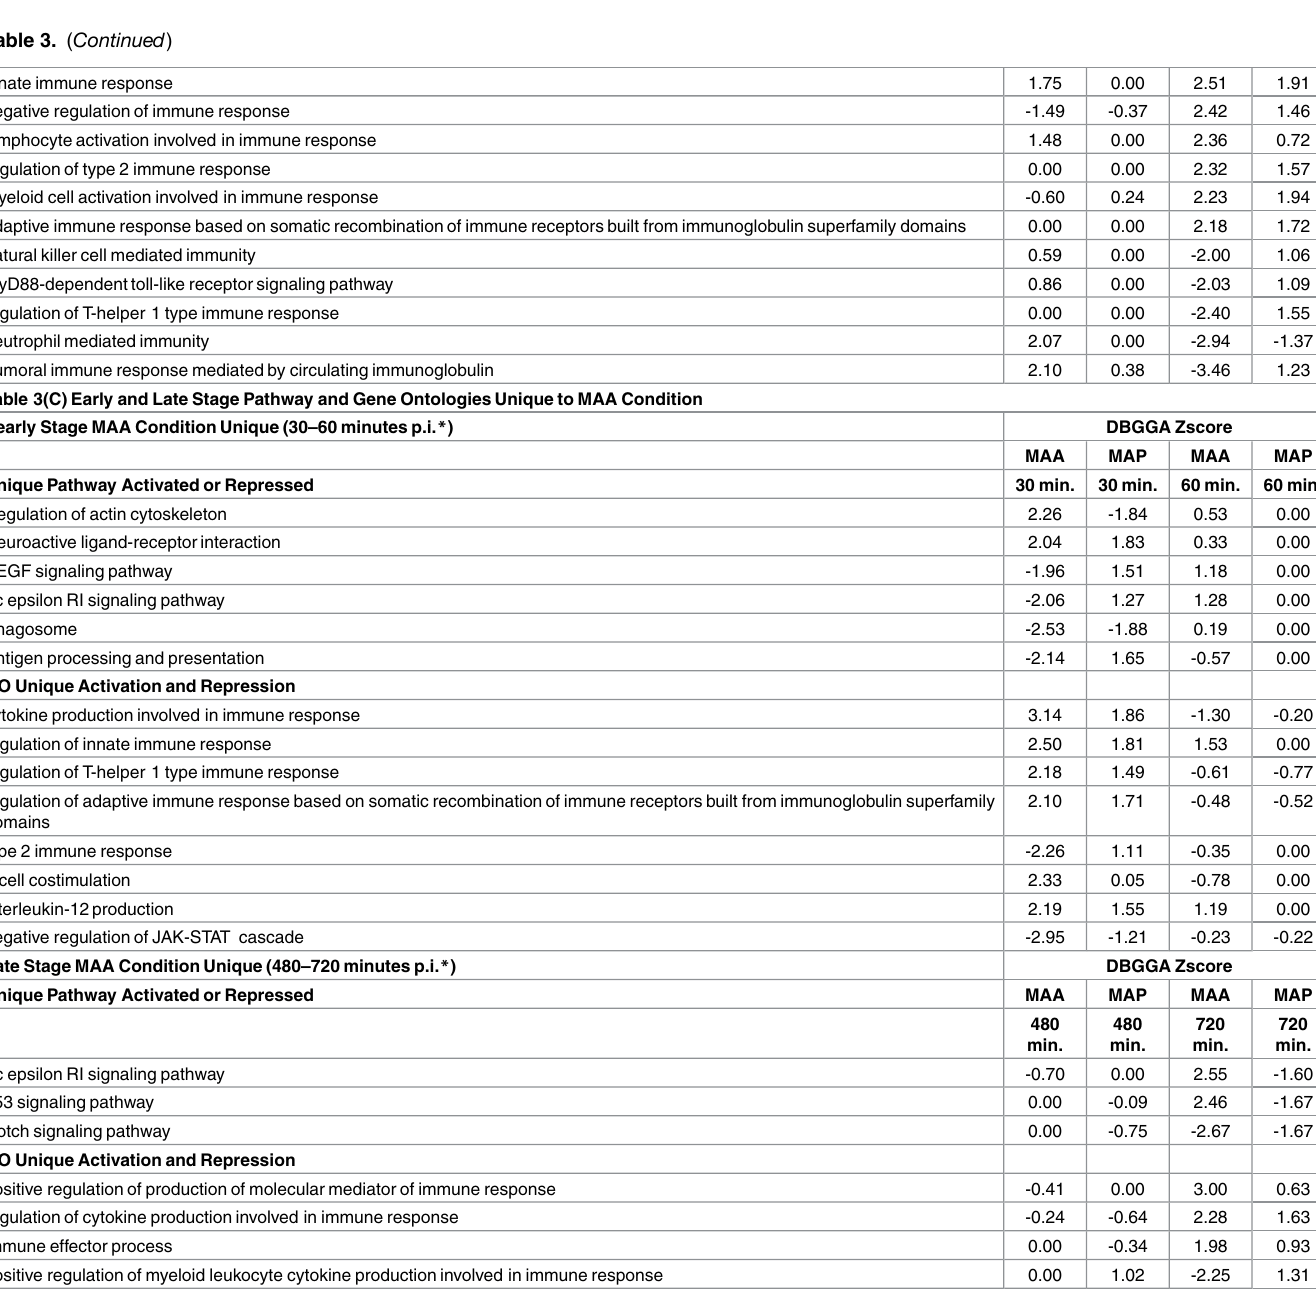
(A) Pathways and GO immune categoriesshowing a reversal in states of activation or repressionbetween MAP and MAA conditionand separated by early and late stages. (B) The pathways and GO categoriesfound to be unique to the MAP condition. (C) The pathways and GO categoriesfound to be unique to the MAA condition separated into early and late